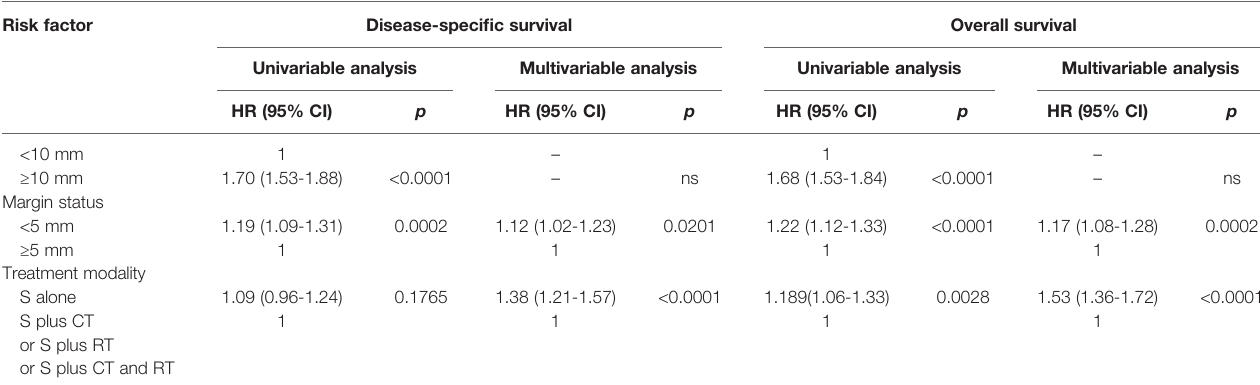
two classi fi cation systems (traditional AJCC versus